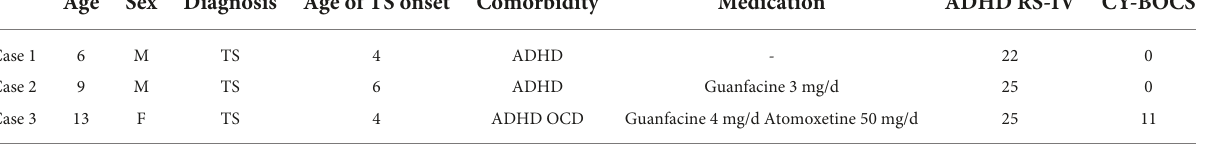
TABLE 1 Clinical characteristic details.